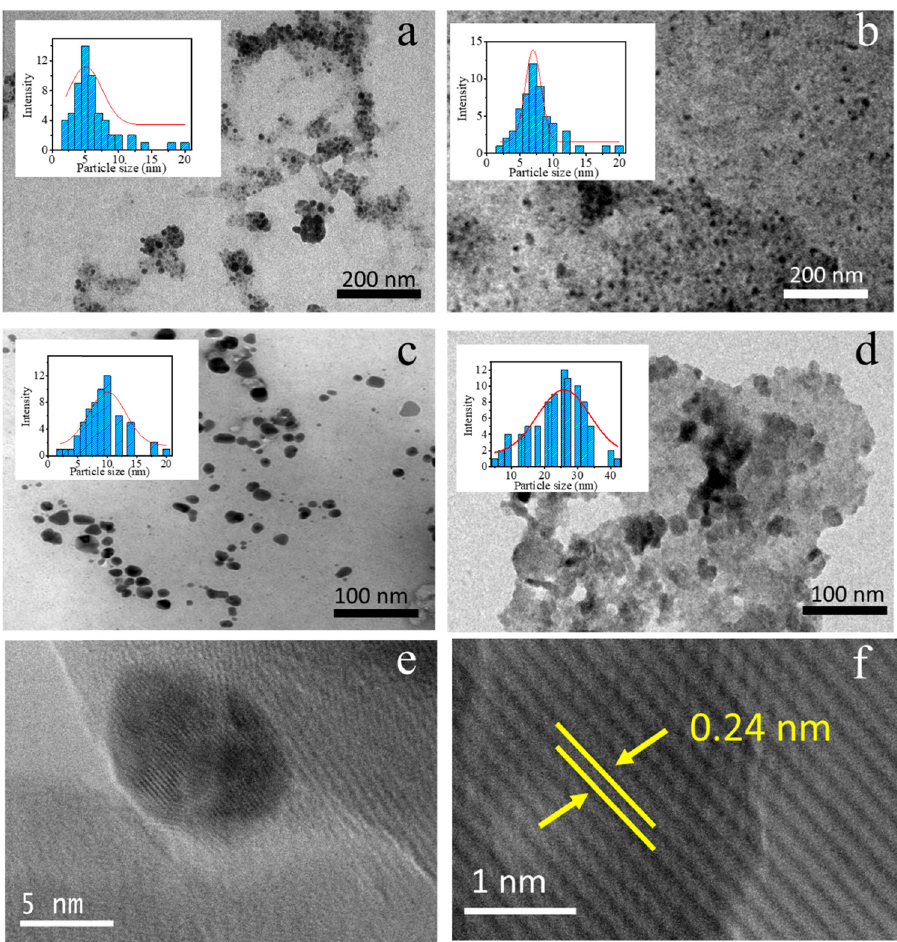
Figure 3: TEM image and particles distribution of ( a ) AuNPs - 0.25, ( b ) AuNPs - 0.5, ( c ) AuNPs - 1.0, ( d ) AuNPs - 2.0, and ( e,f ) HRTEM images of